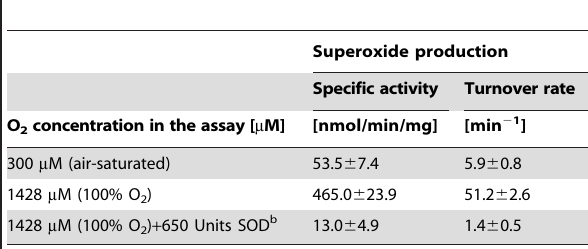
Table 3. NADH-mediated superoxide production by HoxFU in the presence of O 2a